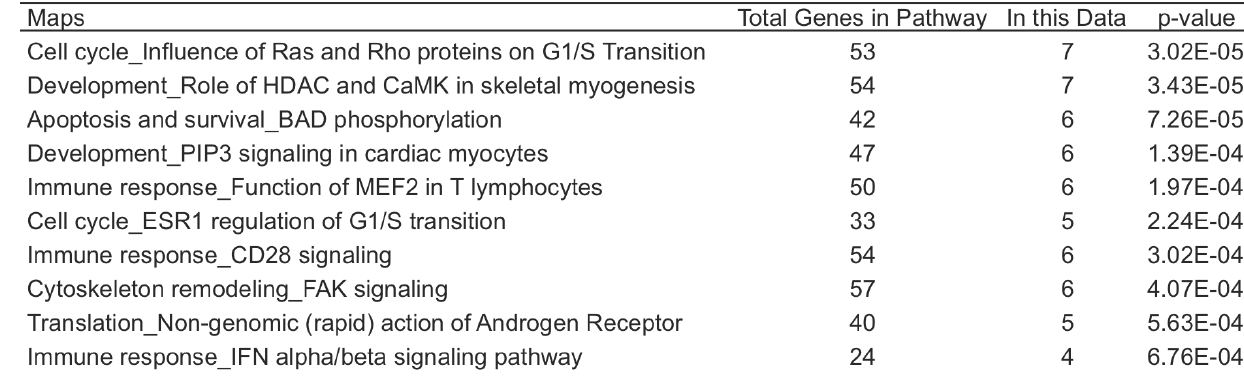
Table 4. Three of four overlapping miRNA target associations. Shown are the enriched associations of miRNA targets identified in at least three of the four CLIP datasets shown in Figure 2.